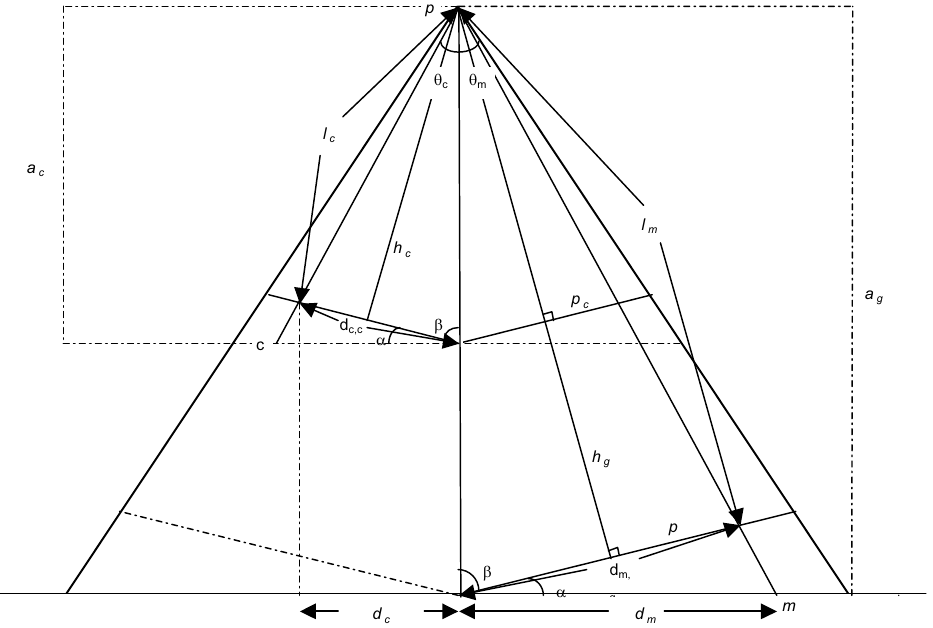
Fig. 1. A vertical representation of the photo fields of the 2 cameras, including the photo plane (p), the cue–counting plane (c), and an observed minke whale (m). The sideward horizontal angle of the cameras is α=16.6 degrees, and p c and p g represents photo lines with a constant distance k c and k g covered by each pixel. This distance is equal to the distance covered by the innermost pixel at the level of respectively the cue– counting plane (c) and the ground